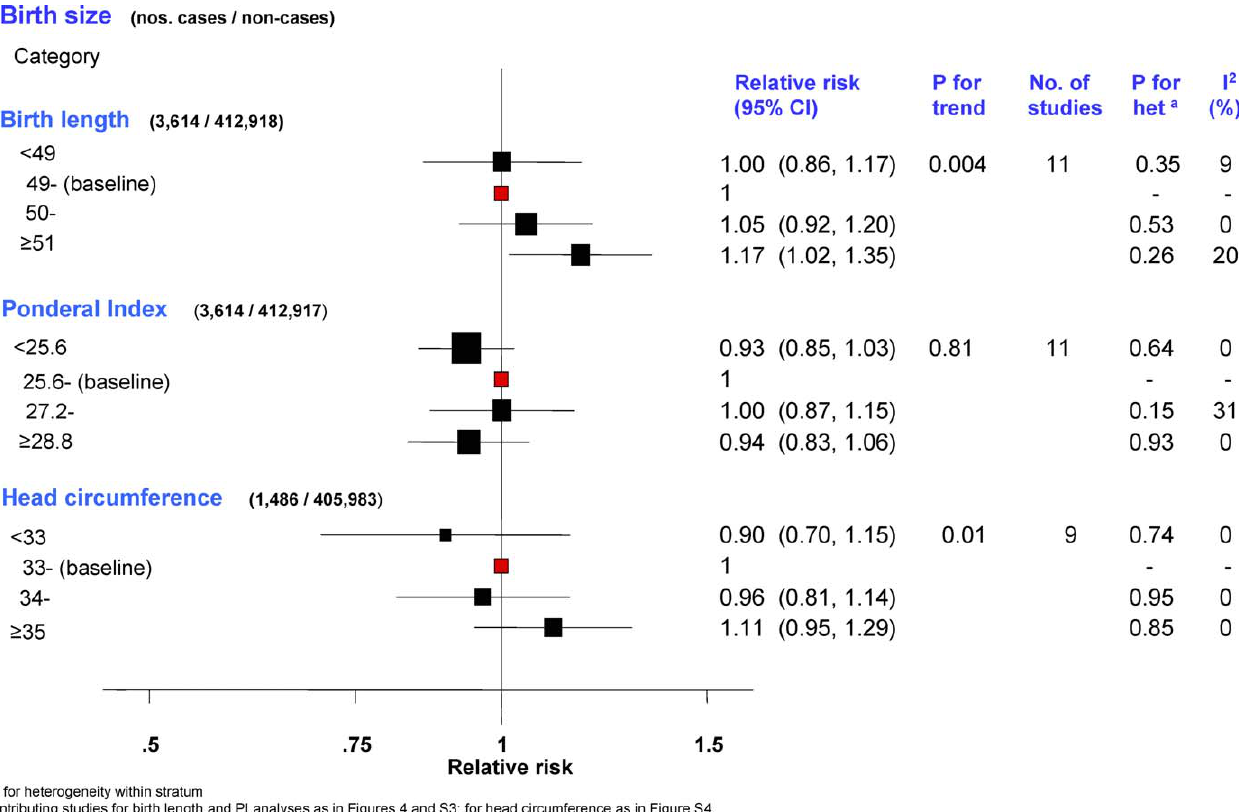
Figure 3. Minimally Adjusted Pooled Breast Cancer RRs in Relation to Categorical Birth Length, PI, and Head Circumference (Singleton Studies Only) The area of the black squares is inversely proportional to the variance (on the log scale).